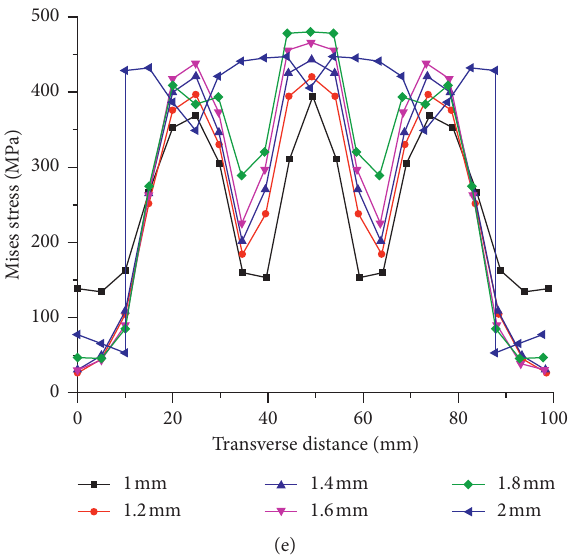
Figure 13: Von Mises stress distributions of the outer layer during the loading process: von Mises stress distribution at (a) h � 2.37mm, (b) h � 21.51 mm, (c) h � 22.34mm, (d) h � 24.83mm, and (e) h � 24.83mm.